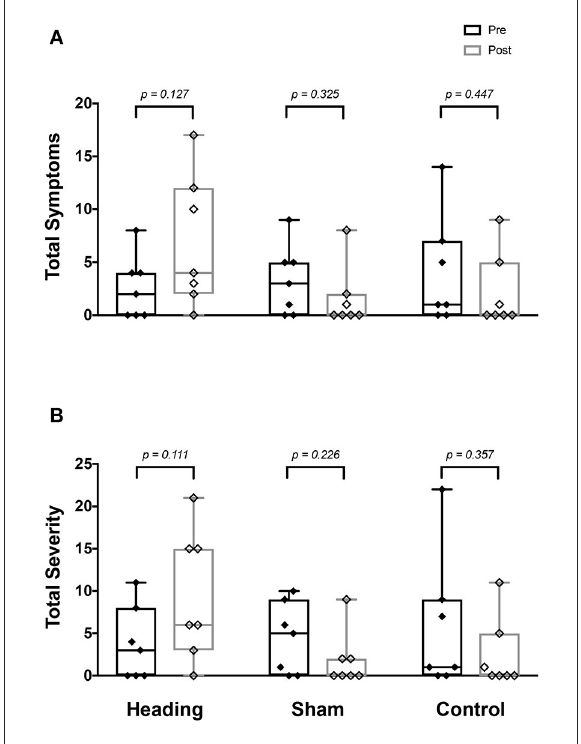
FIGURE1 SCAT3 symptom metrics measured before and after exposure to heading, sham, and control conditions across all participants. Boxes span upper and lower quartile with median indicated; whiskers represent range. SCAT3 metrics describe (A) total number of symptoms reported, and (B) summed severity of all symptoms reported.